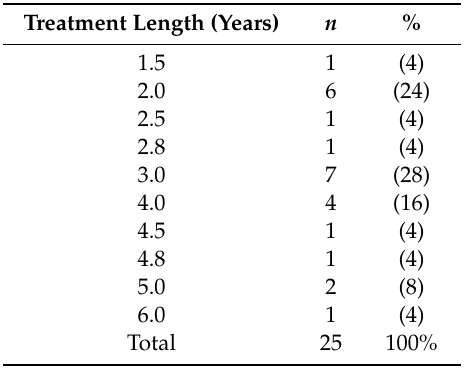
Table 2. Length of orthodontic treatment as documented in 25 cases.